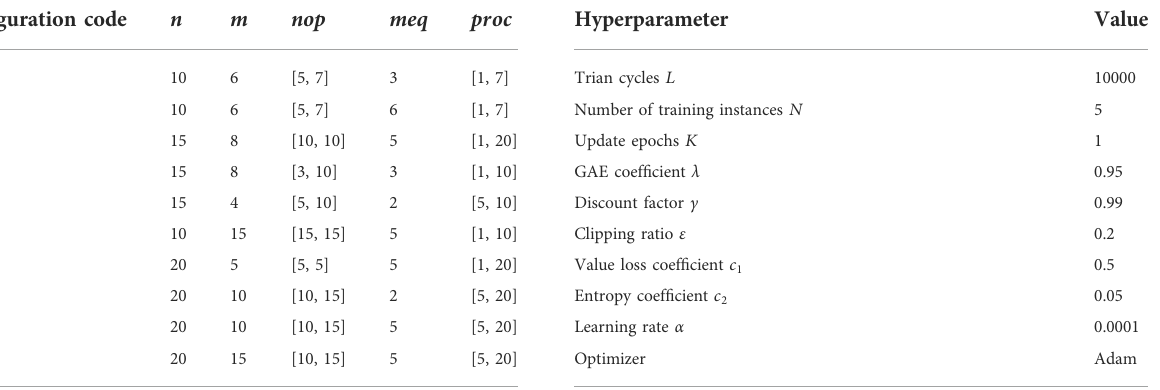
TABLE 4 Brandimarte ’ s benchmarks.